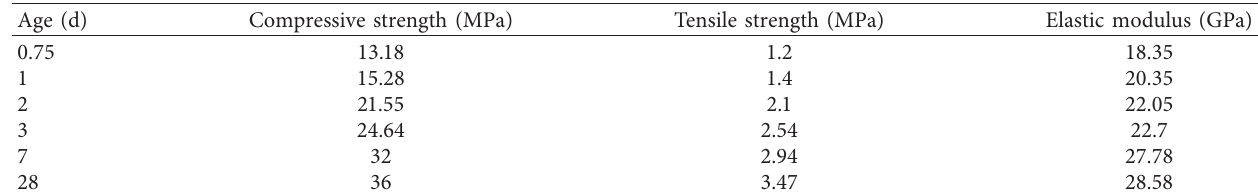
Table 5: Mechanical characteristics of